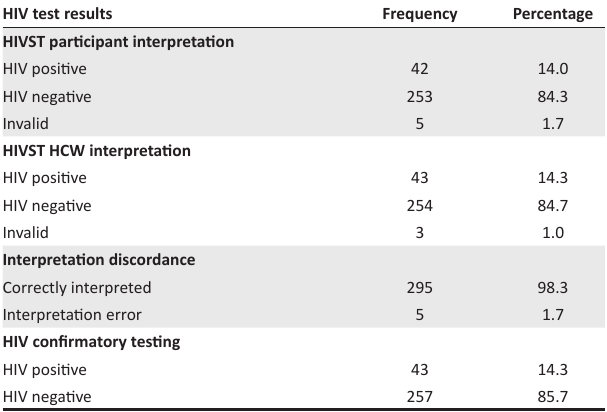
TABLE 2: Human immunodeficiency virus (HIV) testing outcomes. Sample size =